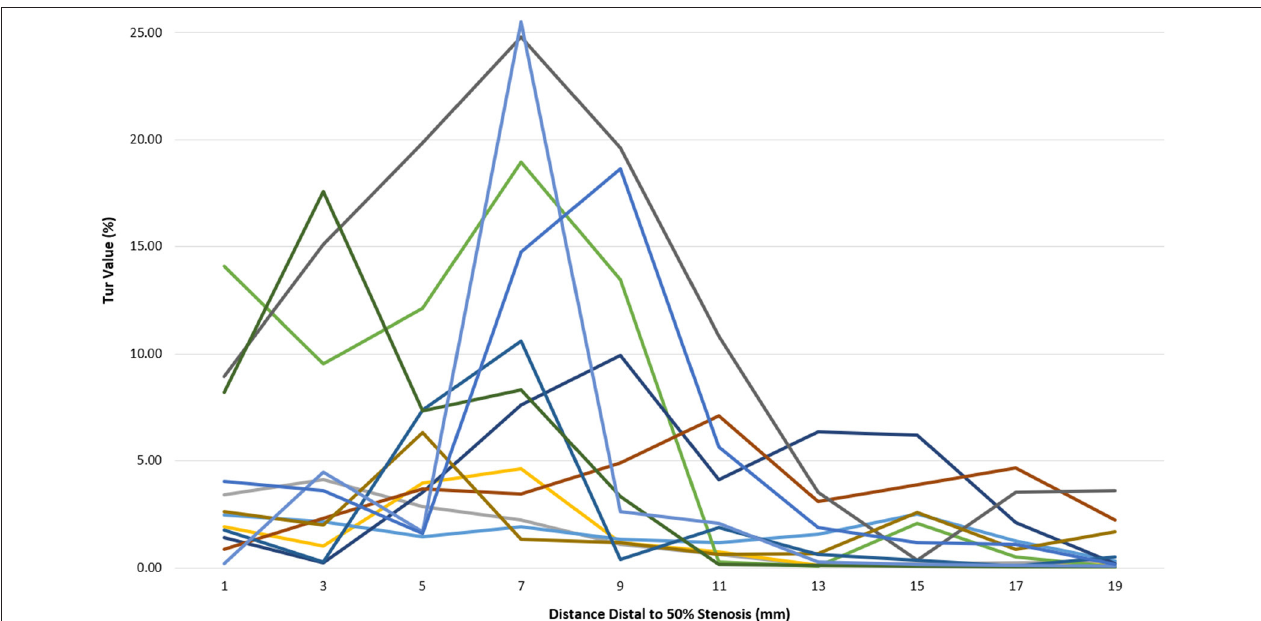
FIGURE 4 | Tur index changes in relation to distance distal to a 50% stenosis in 12 canine femoral arteries.